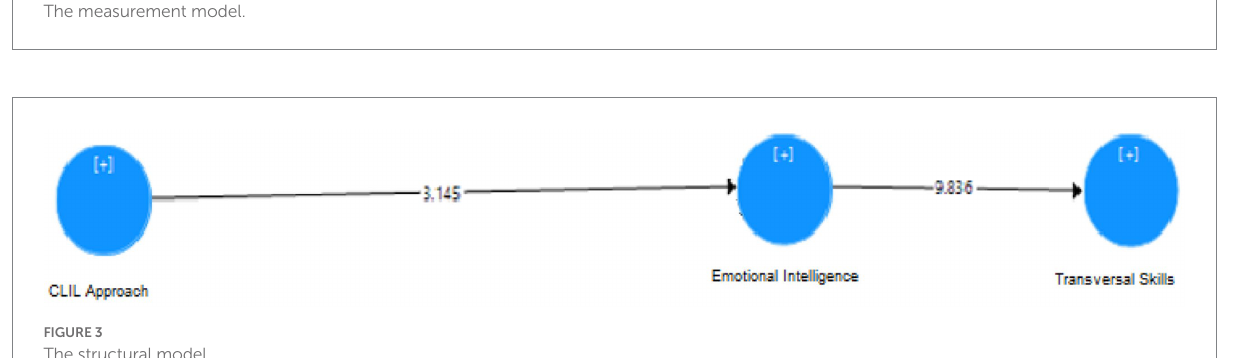
FIGURE 2 The measurement model.